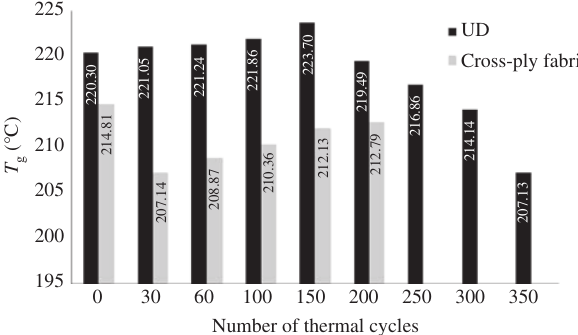
of laminates versus the number of g